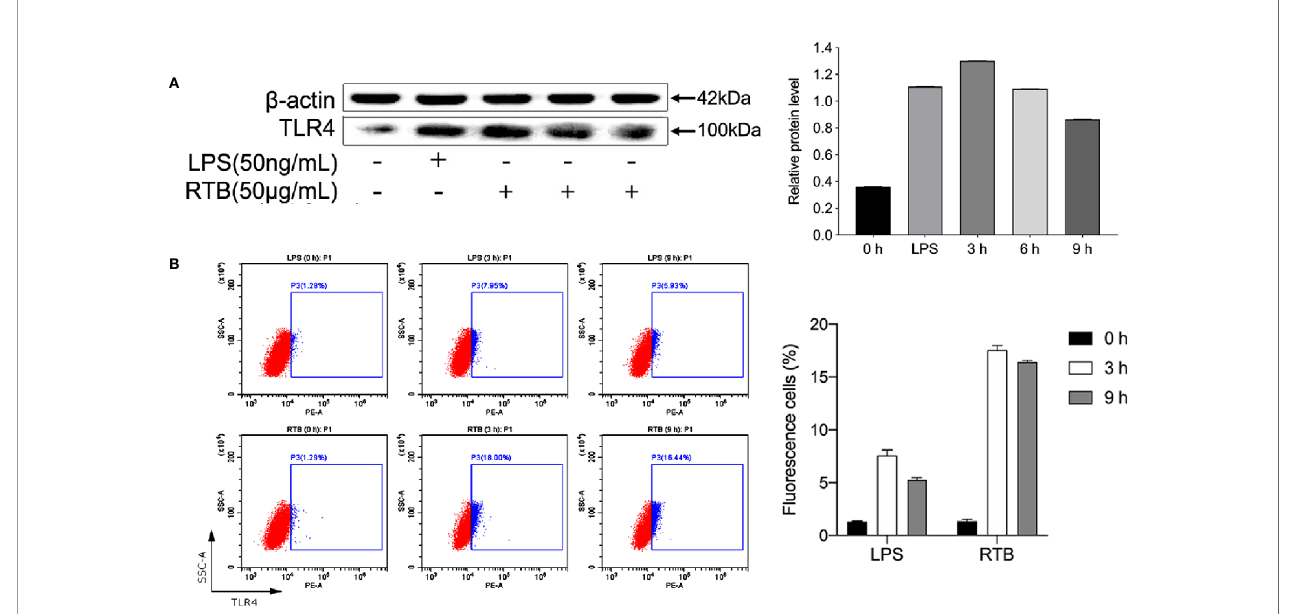
FIGURE 2 | The analysis of TLR4 expression on RTB-treated RAW264.7 cells. (A) Expression levels of TLR4 were detected by western blotting. Cells were treated with RTB (50 m g/mL) for 3, 6, or 9 h or LPS (50 ng/mL) for 6 h. Whole cell lysates were prepared and TLR4 protein expression checked by western blotting using a speci fi c antibody against TLR4 or b -actin. Relative protein level represents the relative ratio of expression of each protein versus actin. (B) TLR4 expression on RAW264.7 cells were analysed by fl ow cytometry. Cells were treated with RTB (50 m g/mL) for 3 or 9 h or LPS (50 ng/mL) for 3 h. TLR4 expressions were examined by fl ow cytometry. Representative results from one of three experiments with similar results are shown. Data represent the mean ± SD from three representative experiments.